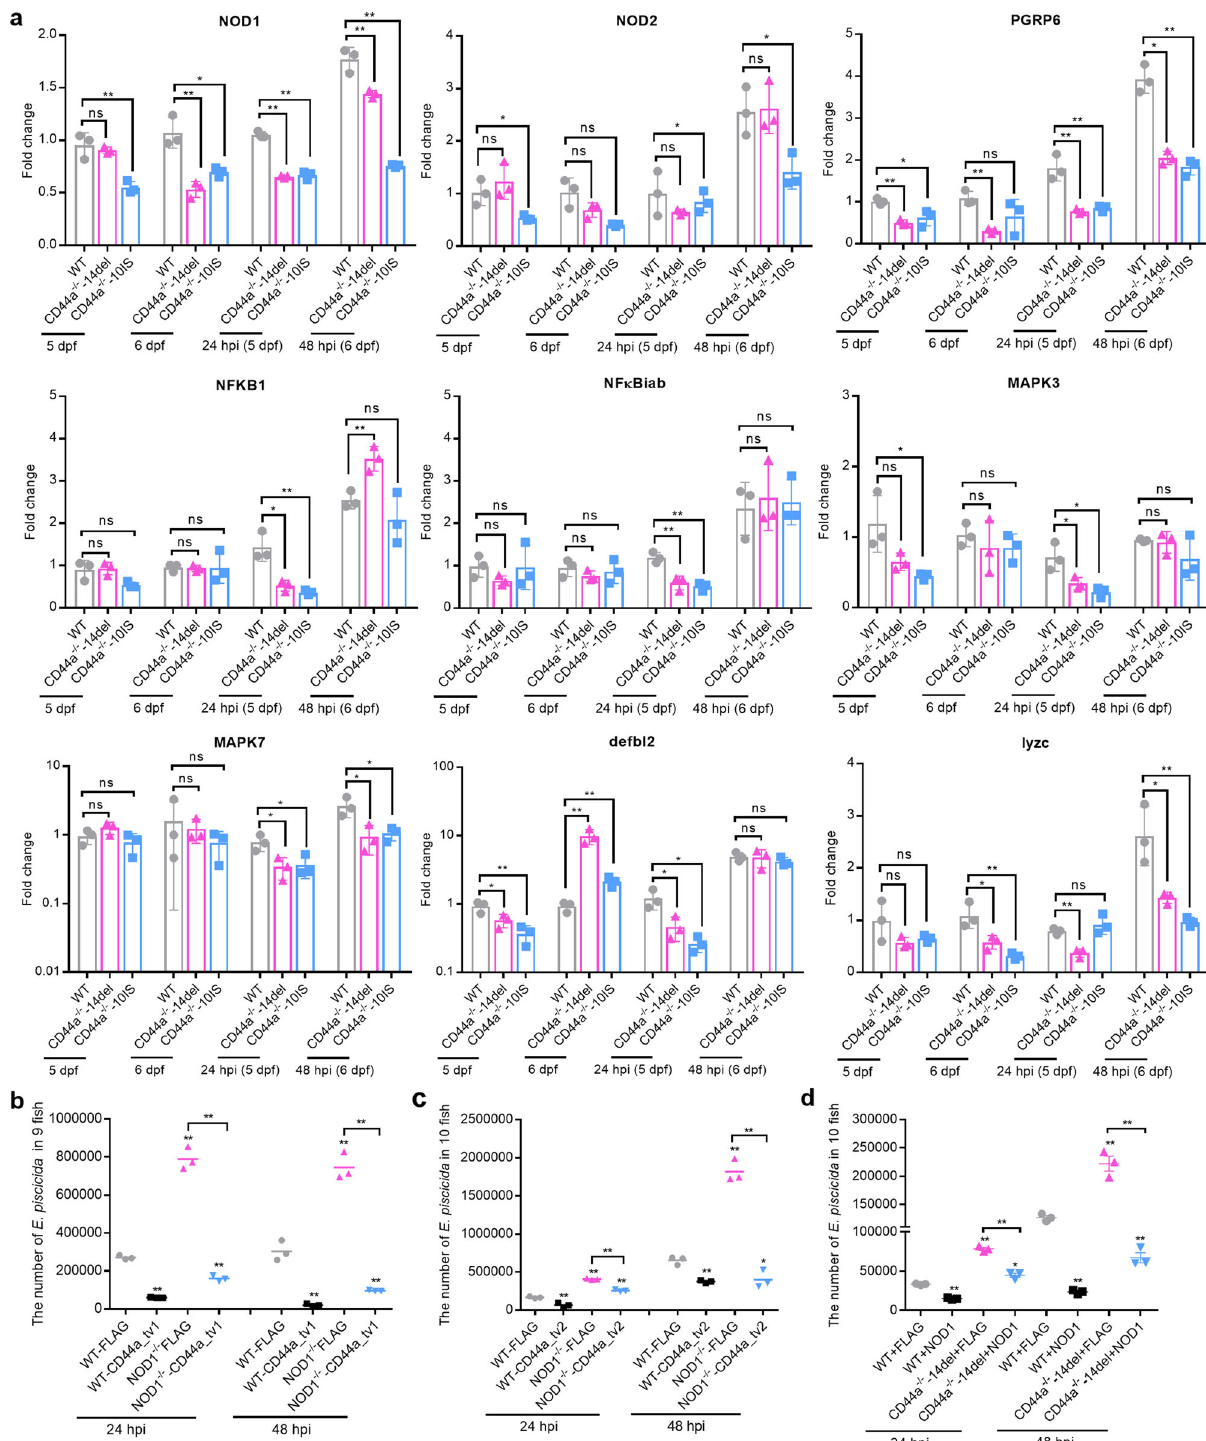
Fig. 2 The antibacterial effects of zebra fi sh CD44a and NOD1 are independent of each other. a The quanti fi cation analysis of mRNA levels of key genes involved in the NOD1-RIPK2 signaling pathway in the WT, CD44a − / − -14del and CD44a − / − -10IS zebra fi sh larvae, as determined by qRT-PCR. Quanti fi cation data represent the expression level of genes compared with those in the WT zebra fi sh. b Zebra fi sh larvae from the WT and NOD1 − / − mutants microinjected with p3×FLAG or CD44a_tv1-FLAG were collected at the indicated post-infection time points, and homogenates were made for CFU counts. c Zebra fi sh larvae from the WT and NOD1 − / − mutants microinjected with p3×FLAG or CD44a_tv2-FLAG were collected at the indicated post- infection time points, and homogenates were made for CFU counts. d Zebra fi sh larvae from the WT and CD44a − / − -14del mutants microinjected with p3×FLAG or NOD1-FLAG were collected at the indicated post-infection time points, and homogenates were made for CFU counts. For a – d , the data are presented as means ± SD ( n = 3). * p < 0.05, ** p < 0.01; ns not signi fi cant.